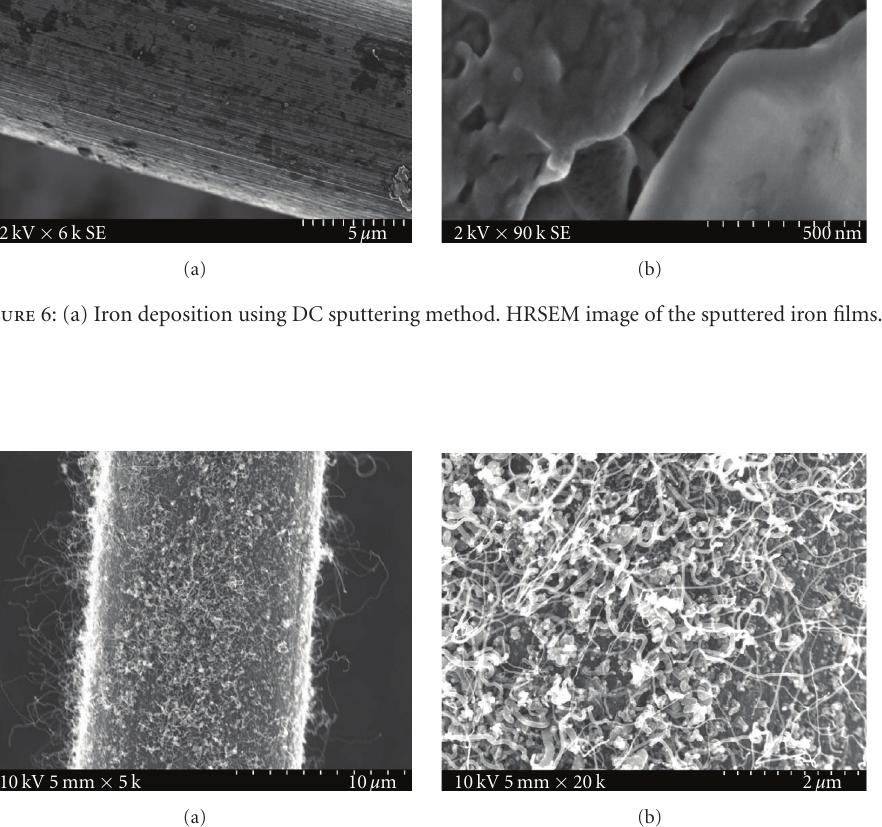
Figure 7: (a) SEM image of CNTs growth on carbon fiber using the iron DC sputtering technique, and (b) close-up image of the CNTs grown via CVD using iron evaporation deposition.